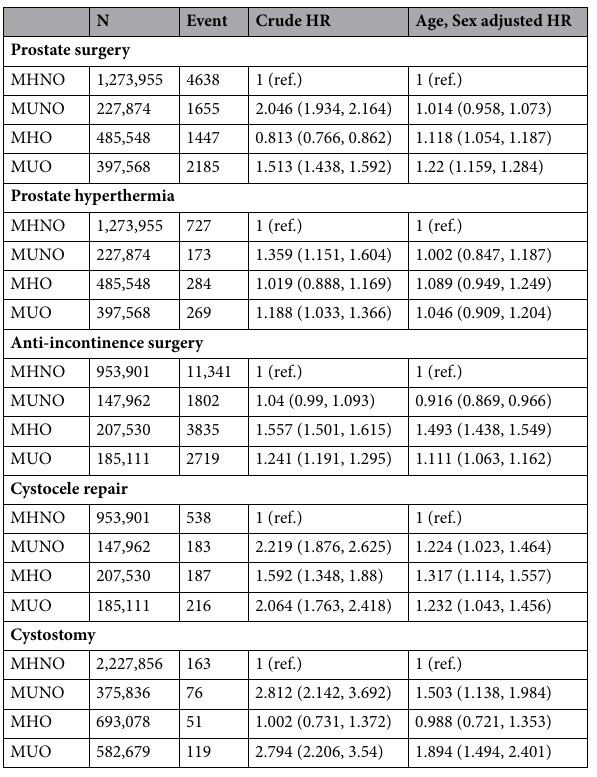
Table 3. Surgery related to urological disorders according to BMI and metabolic health status. Data are expressed as HRs (95% confidence interval). MHNO metabolically healthy non-obese; MHO metabolically healthy obese; MUNO metabolically unhealthy nonobese; MUO metabolically unhealthy